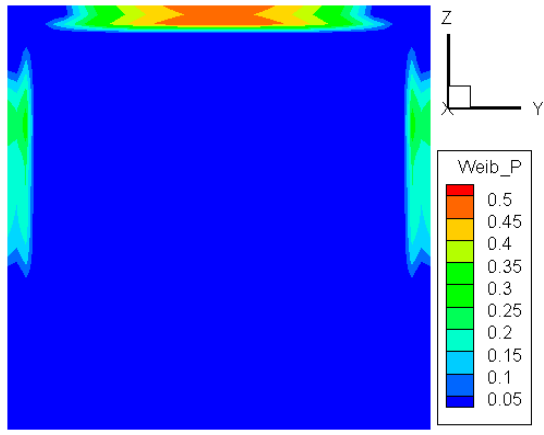
Figure 4. Probability distribution of crack initiation via the three-parameter Weibull distribution.